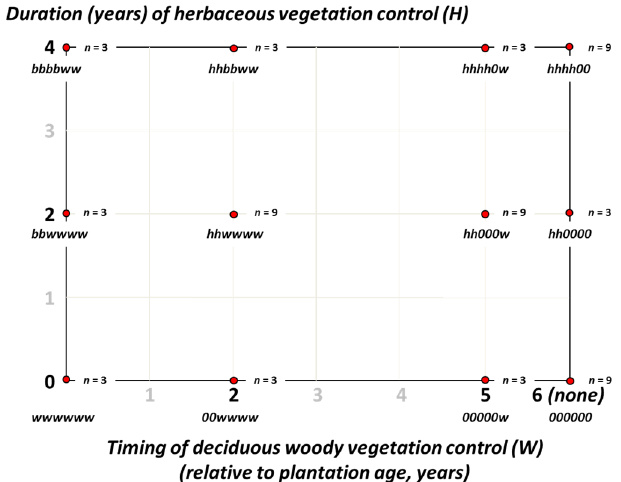
Figure 1. Response-surface design for studying the effects of competition on white pine establishment and growth. The combinations of duration of herbaceous vegetation control ( H ) and timing of deciduous woody vegetation control ( W ) lead to 12 treatments (red circles). These treatments may be coded in terms of “0” no vegetation control, “ w ” woody control, “ h ” herbaceous control, and “ b ” both woody and herbaceous control, with 6 characters representing the first 6 years of the experiment. Each of the 4 corners and center points on the grid were replicated 3 times. The entire response grid was blocked on 3 deciduous woody densities (5000, 10,000, and 15,000 stems/ha), requiring a total of 60 plots (those with woody control in year 0 being common to each density). Reference treatments (not shown) include complete vegetation control ( bbbbbb , n = 3) and operational broadcast release ( 00b000 , n = 3 × 3 densities). The entire experiment at each site required 72 plots.